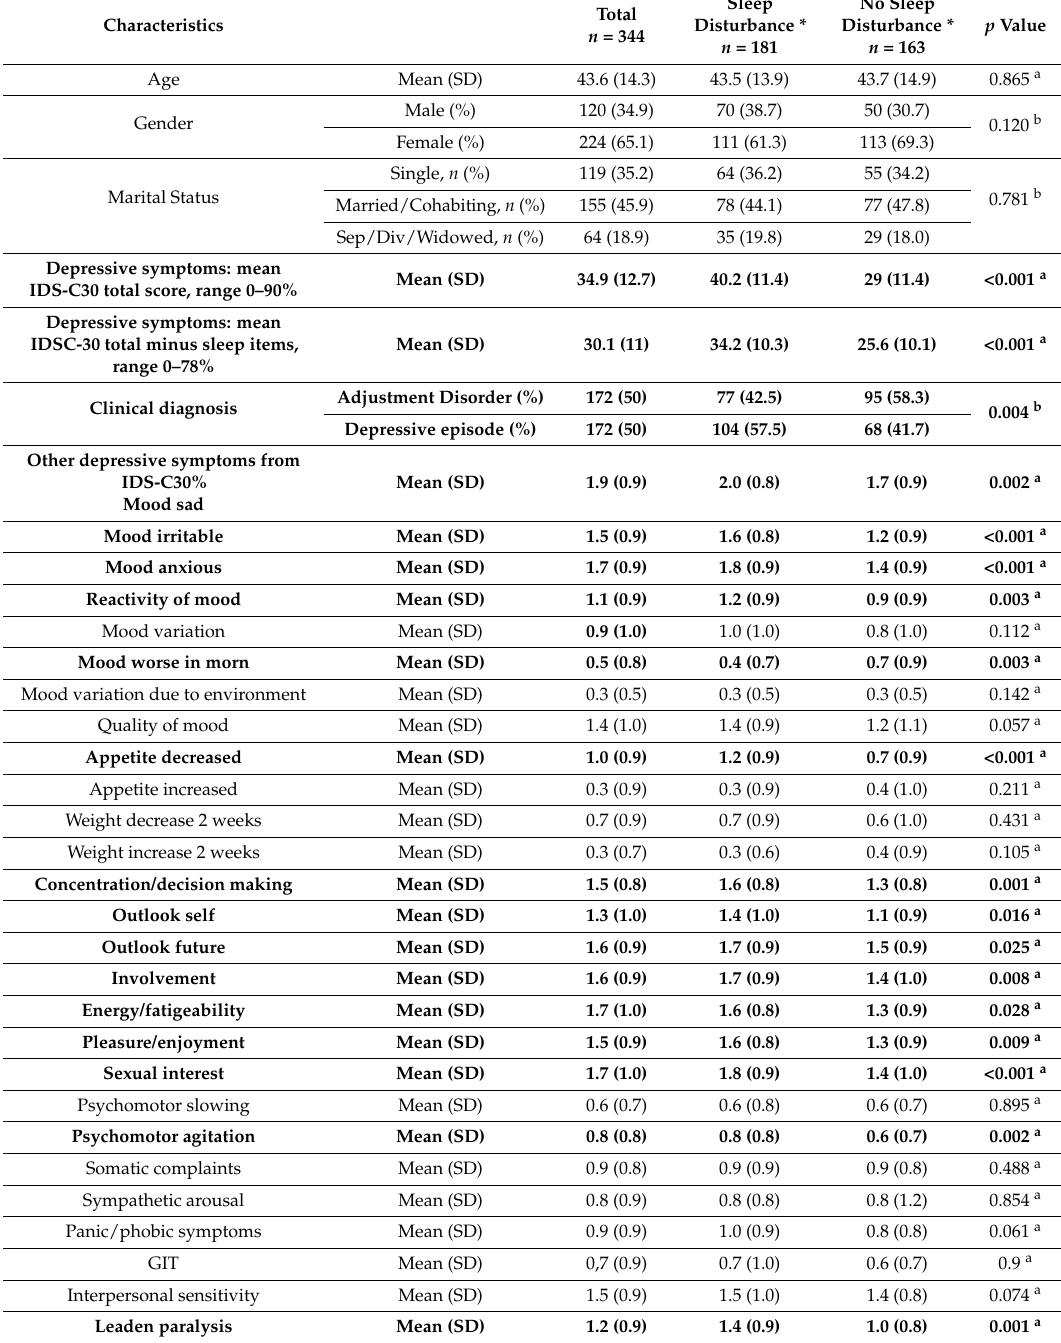
Table 2. Demographic and clinical characteristics of patients divided by sleep